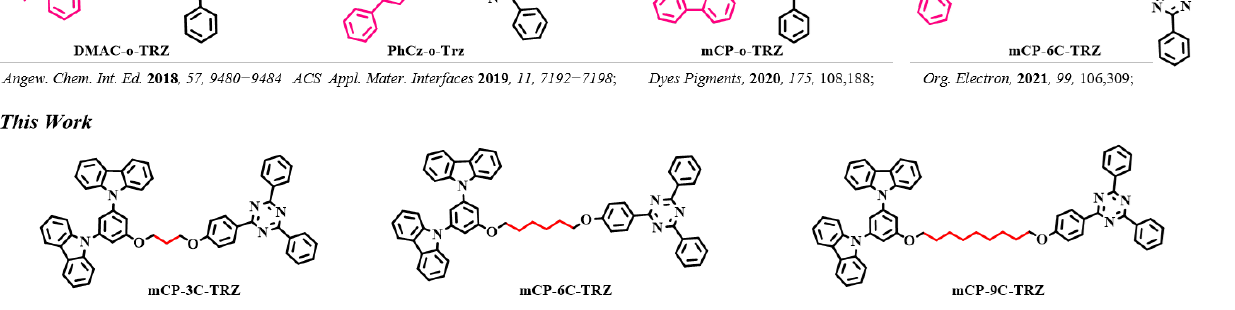
Figure 1. Molecular structure and design strategy of this work.